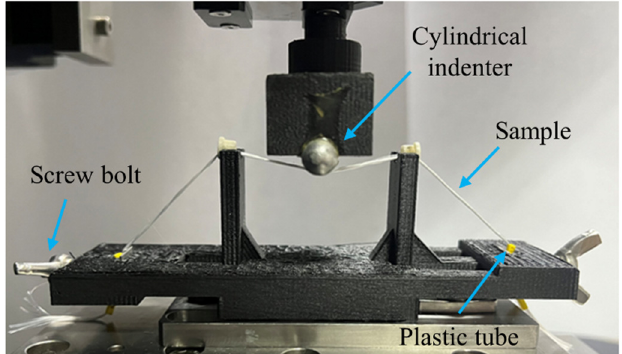
Figure 1. The picture of the bending test setup developed in the laboratory.